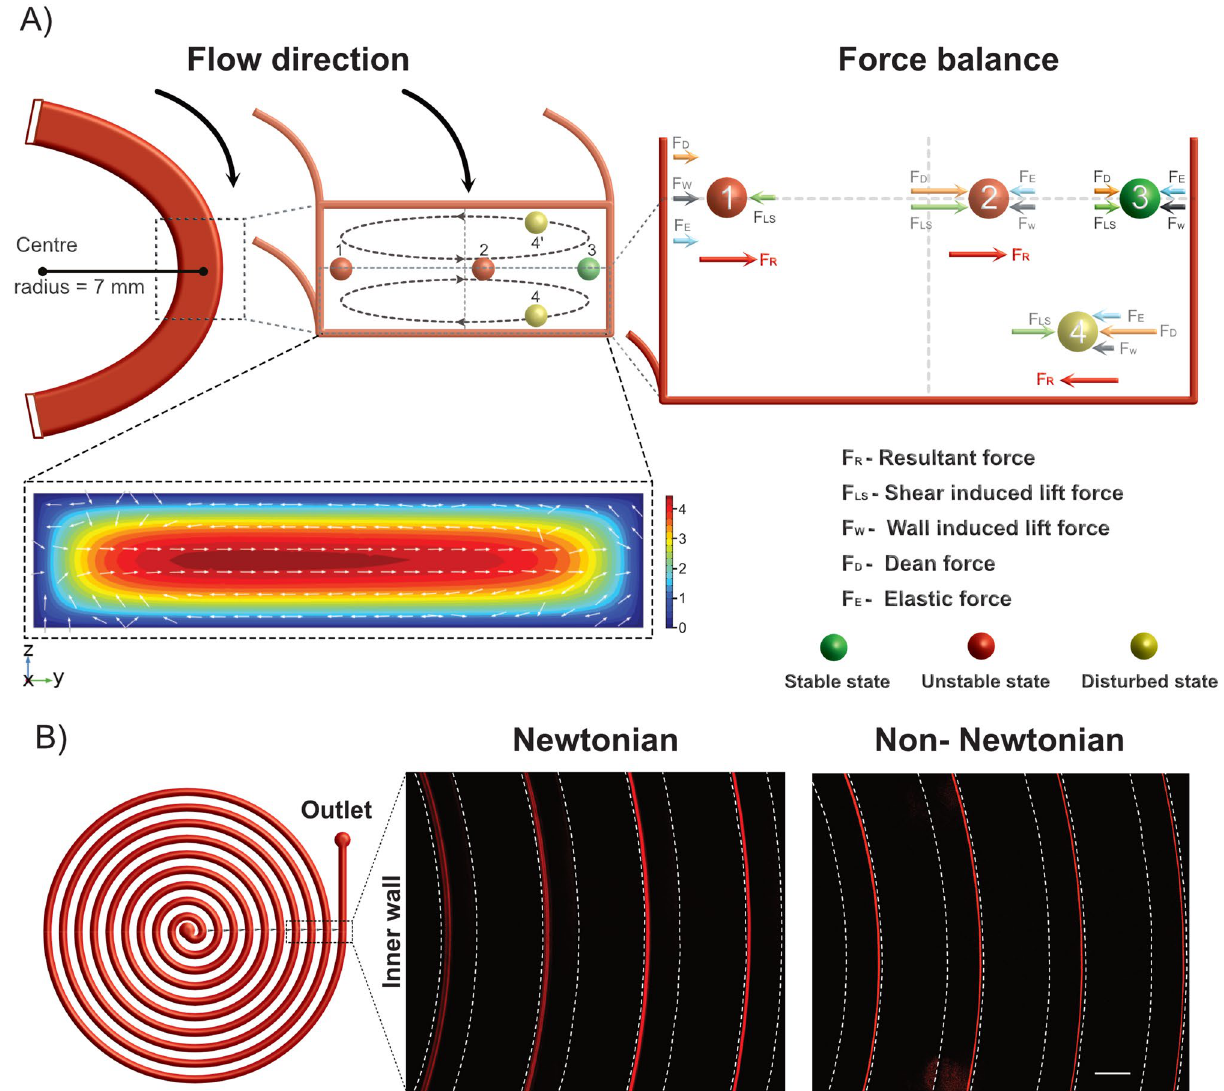
Figure 1. Overview of particle focusing principle in spiral microchannels. ( A ) Schematic illustration of particle focusing in elasto-inertial microfluidics. Under the influence of Dean drag forces (F D ), particles migrate along the Dean vortices, and depending on the position the particles experience additional strong inertial lift forces (F LS and F W ) and elastic forces (F E ). How these forces acting on a particle focused in a distinct point (positions 1–4) are highlighted. Note, there are vertical lift and viscoelastic forces acting on the particles but are negligible at the center line. Inset, COMSOL simulation showing a of a skewed mean flow (contours) and cross-sectional flow (arrows). ( B ) Inertial and elasto-inertial particle focusing. Fluorescence image of 15 µm particles flowing through the spiral in Newtonian (left) and non-Newtonian (right) fluid using PEO as elasticity enhancer. In a Newtonian fluid, the particles are focused at the inner wall and for Non-Newtonian fluid at the outer wall. Scale bar: 500 UD h ) , where ρ , U, and μ are the density, average importance of inertia over viscous effects, is defined as Re = ( ρ µ fluid velocity, and dynamic viscosity respectively. The Weissenberg number describes the relative ratio of elastic 2 (cid:31) Q ) 50 , where λ is the relaxation time of the polymer additives. The to viscous properties and is defined as Wi = ( hw 2 ratio between these two parameters gives the elasticity number El = ( W i Re ), which relates elastic to inertial contri- D h butions. Dean number, De = ( Re c (cid:31) 2 R ) , is a measure of the magnitude of the Dean flow in flows through curved channels. Using COMSOL Multiphysics, we modelled the characteristic flow of curved channel that consisted of a skewed mean flow and the development of a cross-sectional transversally symmetrical cell flow (see Fig. 1 inset). The details of the force components is discussed in more detail in the results.